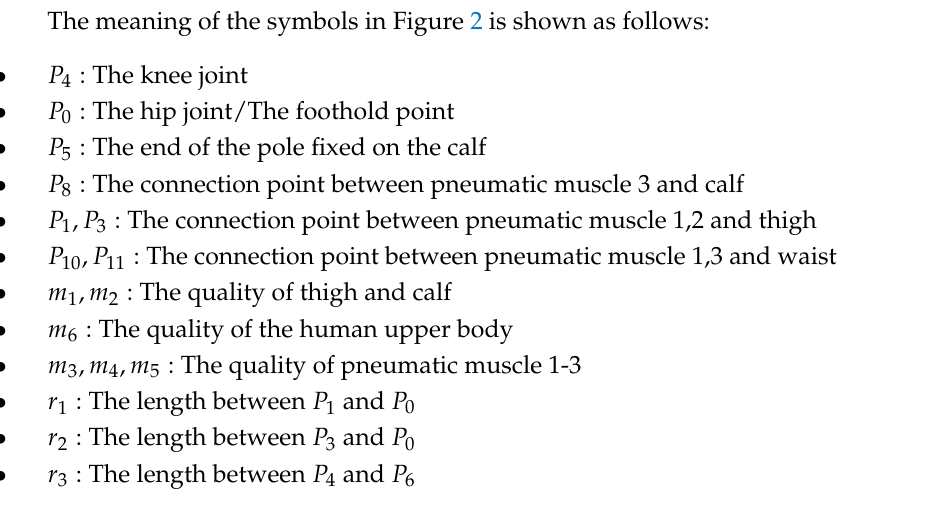
Figure 2. Swing phase model ( Left ) and Stance phase model ( Right